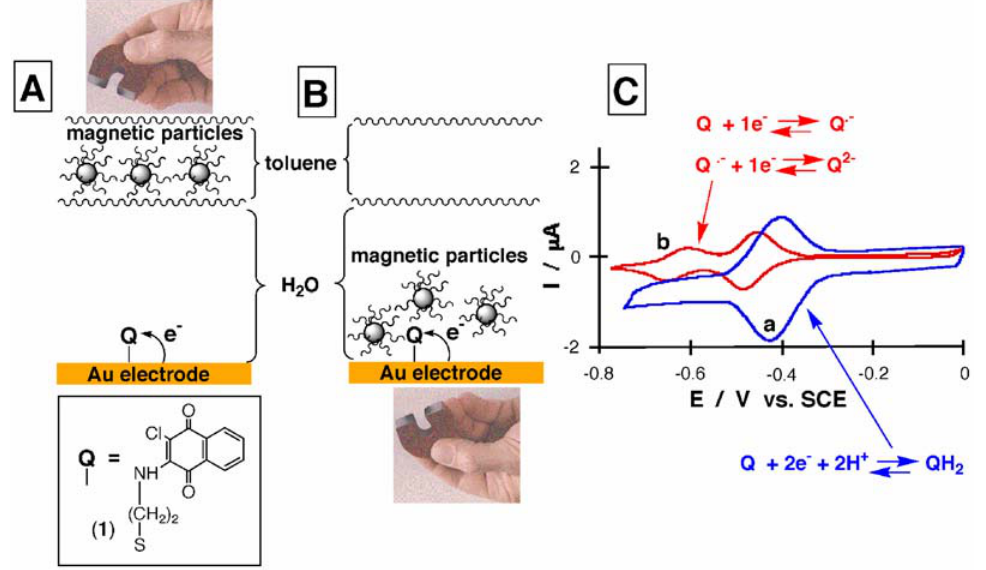
Figure 1. Magneto-controlled reversible translocation of the hydrophobic magnetic NPs between an organic phase, atop the aqueous electrolyte, and the electrode surface: (A) The magnetic NPs are retracted from the electrode surface and the electrode is activated towards the aqueous-type electrochemistry of the surface-confined quinone ( 1 ). (B) The electrode surface is blocked by the hydrophobic magnetic NPs attracted to the electrode by the external magnet, while the surface- confined quinone ( 1 ) reveals the non-aqueous type electrochemistry. (C) Cyclic voltammograms of the system consisting of the surface-confined quinone ( 1 ): a) When the hydrophobic magnetic NPs